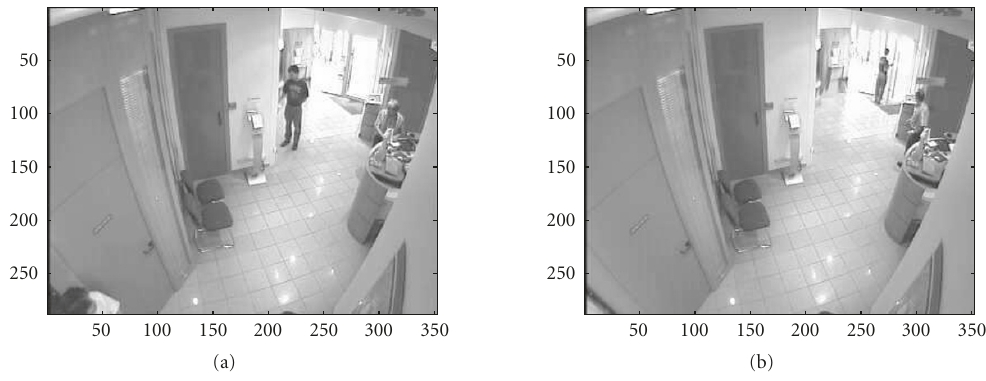
Figure 3: Bank dataset: two segments detected in the no attack scenario: (a) a subject enters the bank, goes to the area where paper slips are stored. Another subject enters the bank and goes to the counter area, (b) exit bank.